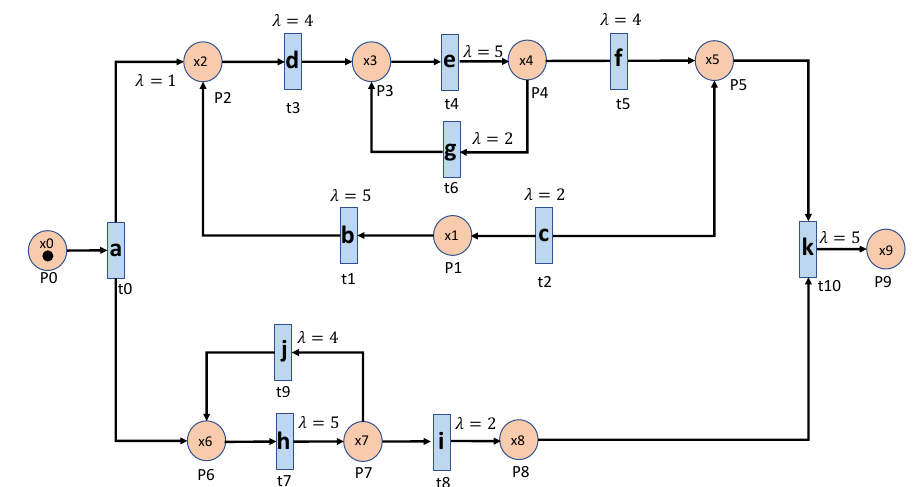
Figure 5. Parallel Loop process with nested loop